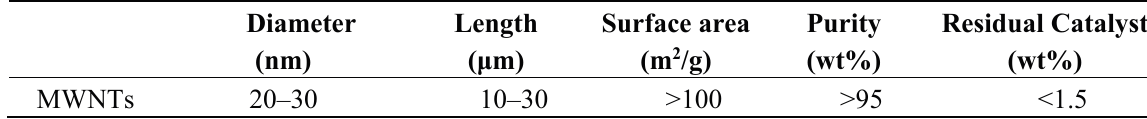
Table 1. Parameters of